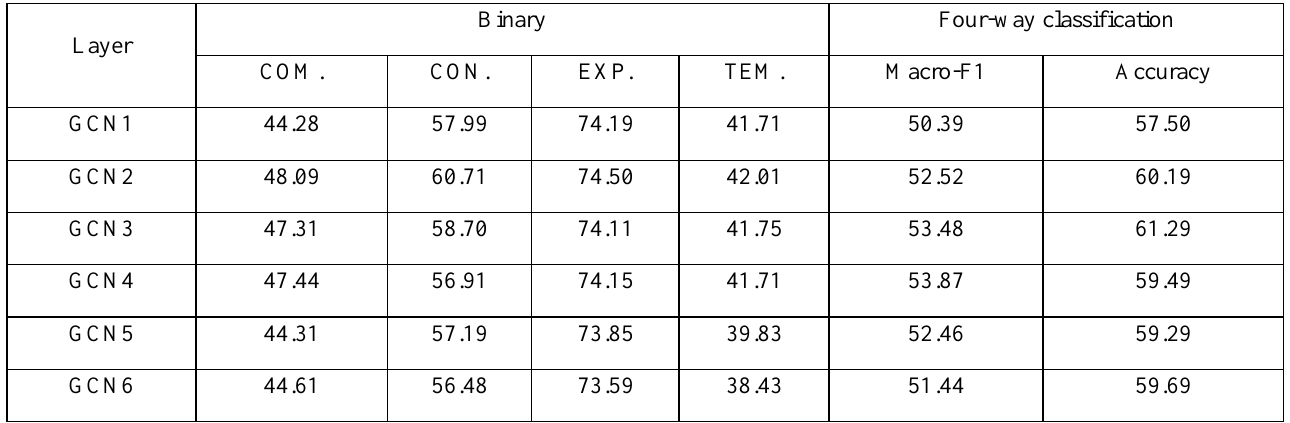
Table 5. Model classification performance based on GCN at different